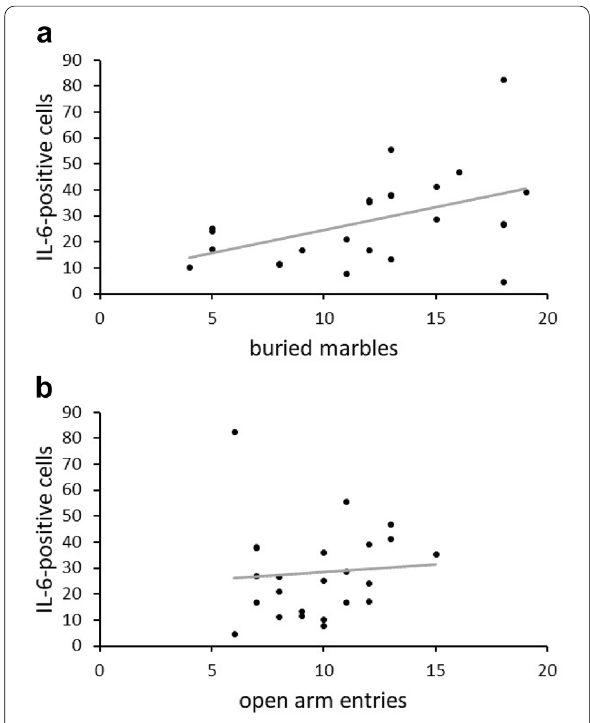
Fig. 4 a The amount of IL-6-positive cells in the whole hippocampus correlate significantly positive with the amount of buried marbles representing anxiety behavior. b No significant correlation of IL-6-positive cells in the whole hippocampus with the amount of open arm entries in the EPM. Each dot represents one subject (n